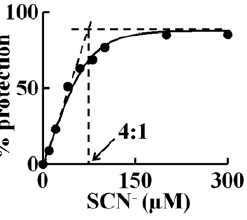
Figure 5. SCN 2 prevents HOCl mediated LPO heme degrada- tion. Fixed amount of LPO (1.5 m M) was incubated with increasing concentrations of SCN 2 (0–300 m M) and the reaction mixtures then treated with fixed amount of HOCl (300 m M). After incubating the reaction for 2 hours, absorbance spectra were collected. The percent- age protection in LPO heme content was calculated from the absorbance at 412 nm and plotted against SCN 2 concentration. The inflection point (which occurs at 4:1 HOCl:SCN 2 ratio) is marked by the dashed line with arrow. The data are averages of three independent